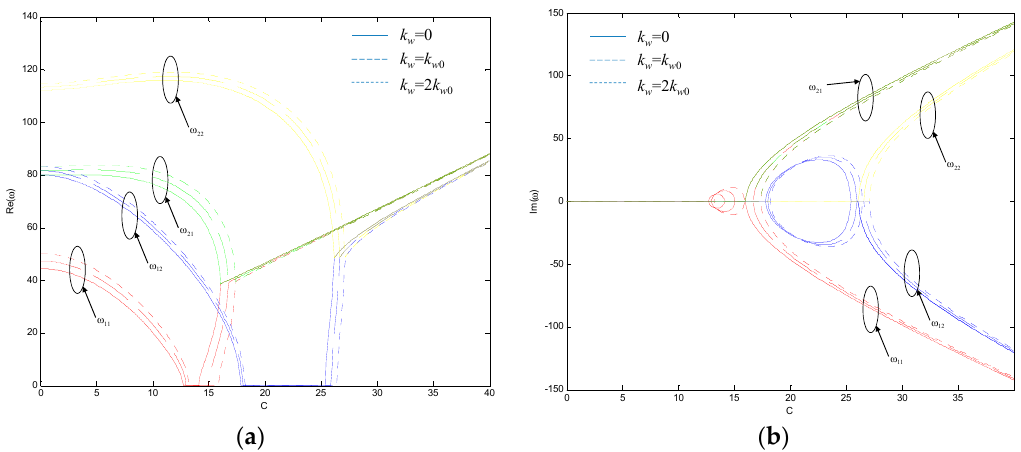
Figure 5. Effect of the Winkler’s modulus k w on dimensionless complex frequencies of the axially-moving nanoplate. Appl. Sci. 2019 , 9 , x FOR PEER REVIEW